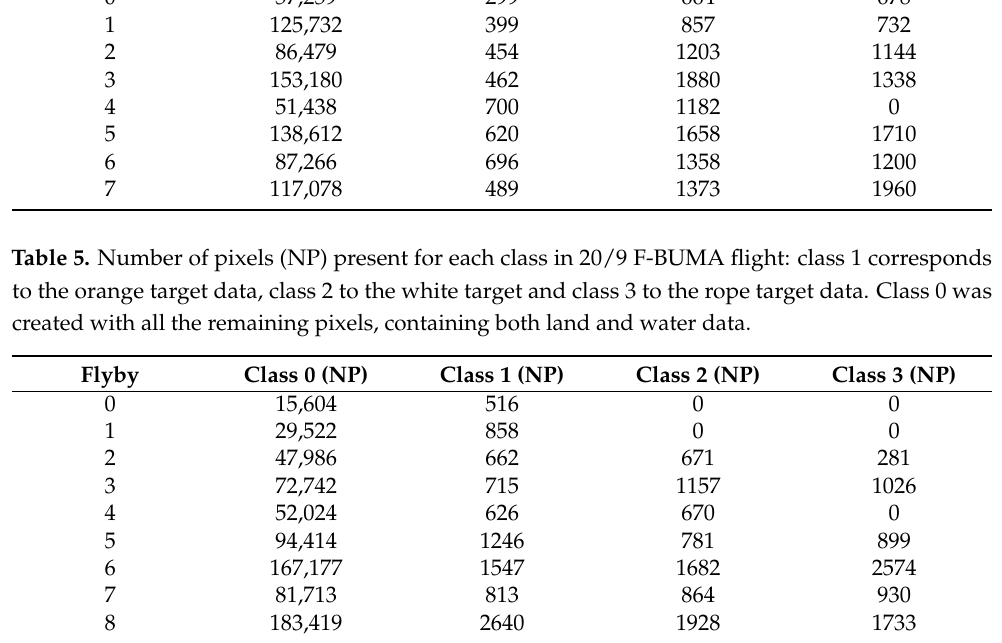
Table 4. Number of pixels (NP) present for each class in 18/9 F-BUMA flight: class 1 corresponds to the orange target data, class 2 to the white target and class 3 to the rope target data. Class 0 was created with all the remaining pixels, containing both land and water data. Flyby Class 0 (NP) Class 1 (NP) Class 2 (NP)